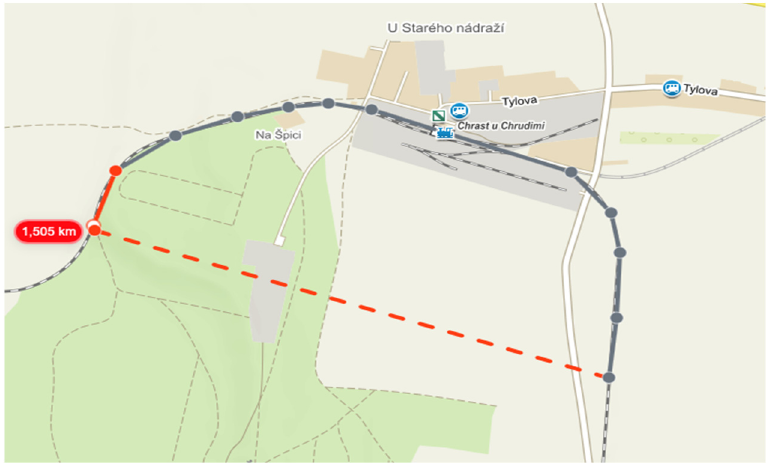
Figure 13. Real vs. air distance.